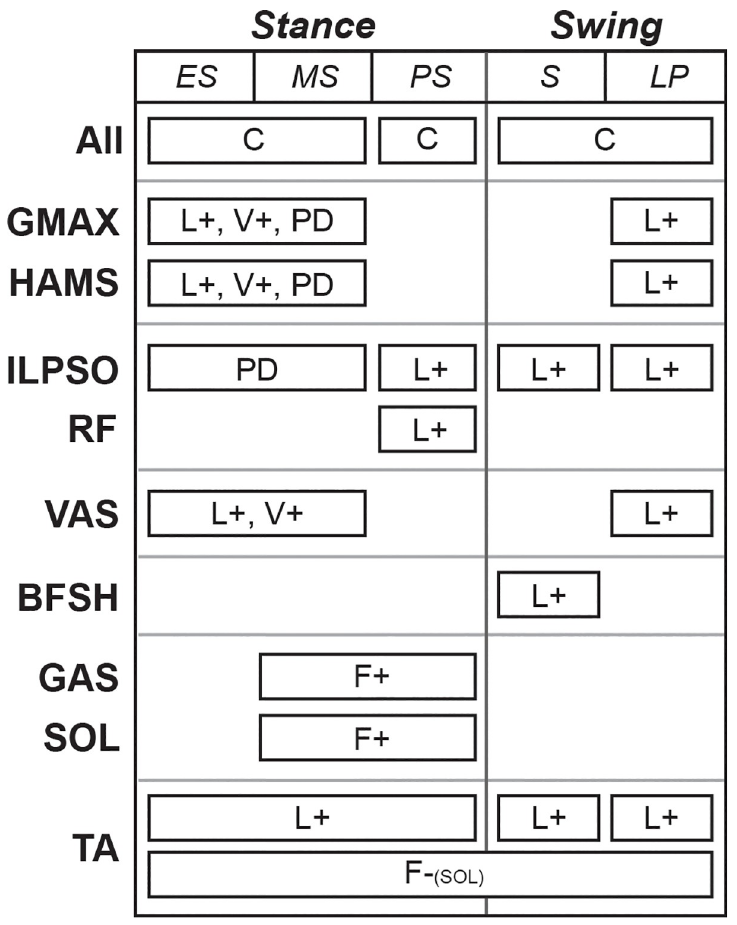
Fig 3. The gait controller used a combination of a state machine and low-level control laws to determine excitations. The state machine had three states in stance (i.e., early stance (ES), mid-stance (MS), and pre-swing (PS)) and two states in swing (i.e., swing (S) and landing preparation (LP)), and it determined when low-level control laws were active. Low-level control laws included constant signals (C), feedback terms based on muscle length (L), muscle velocity (V), and muscle force (F), and proportional-derivative control (PD) based on the pelvis tilt angle. Positive and negative feedback are denoted by (+) and (-), respectively. All feedback laws based on muscle states acted upon the same muscle, except for a negative force feedback from the soleus to the tibialis